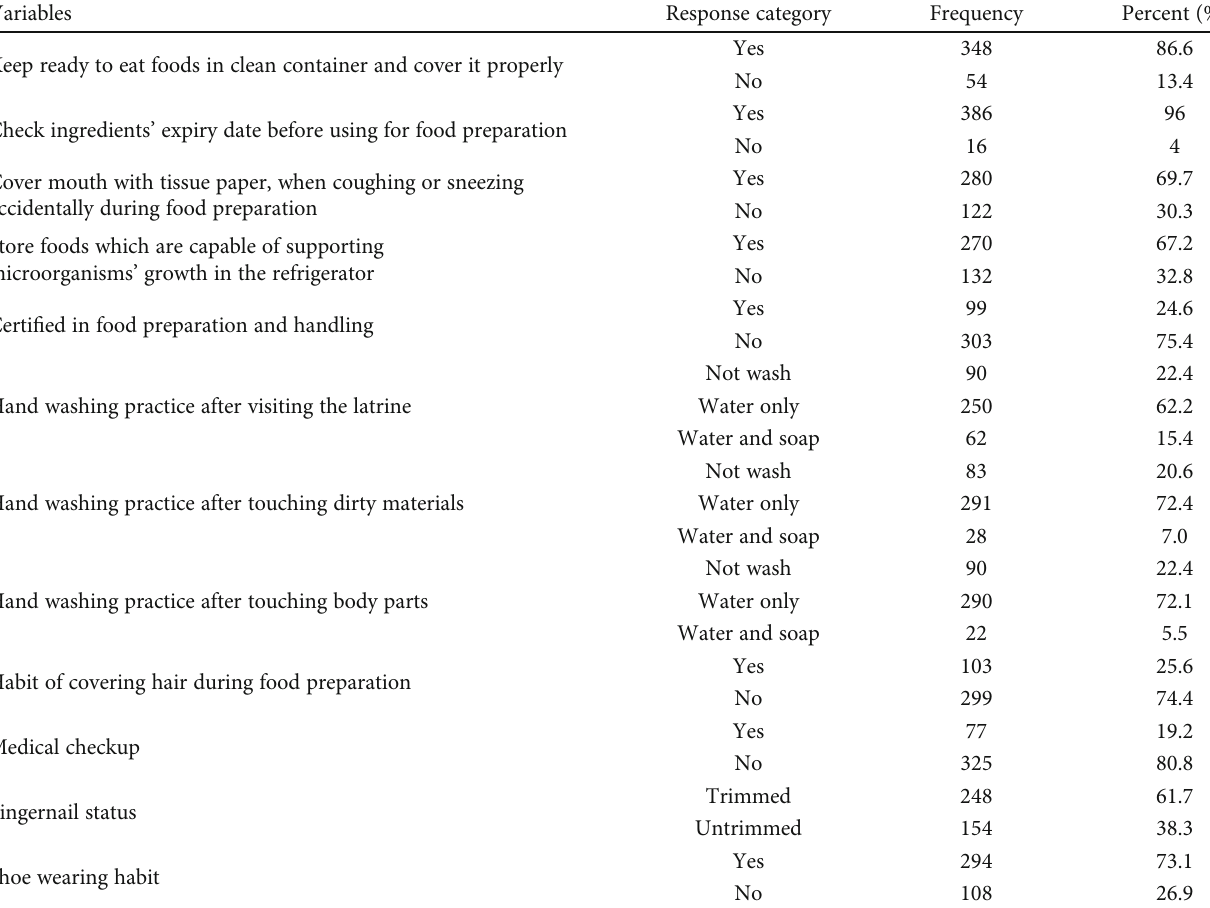
Table 3: Personal hygiene-related factors of food handlers working in catering establishments in Dawuro Zone, South-Western Ethiopia, March to July 2019 ( N = 402